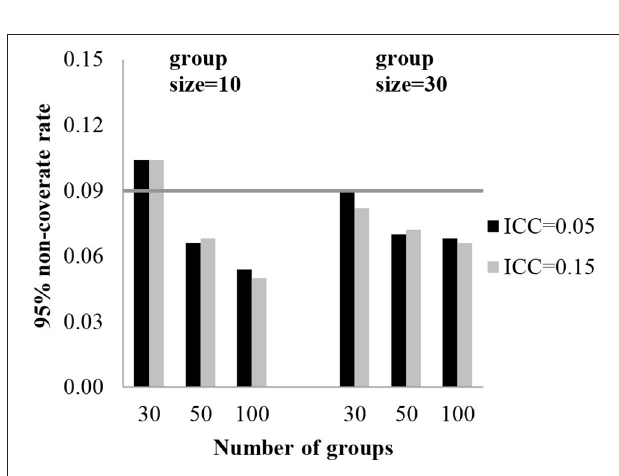
FIGURE 3 | 95% coverage rate for level-3 fixed effect standard error ( γ 101